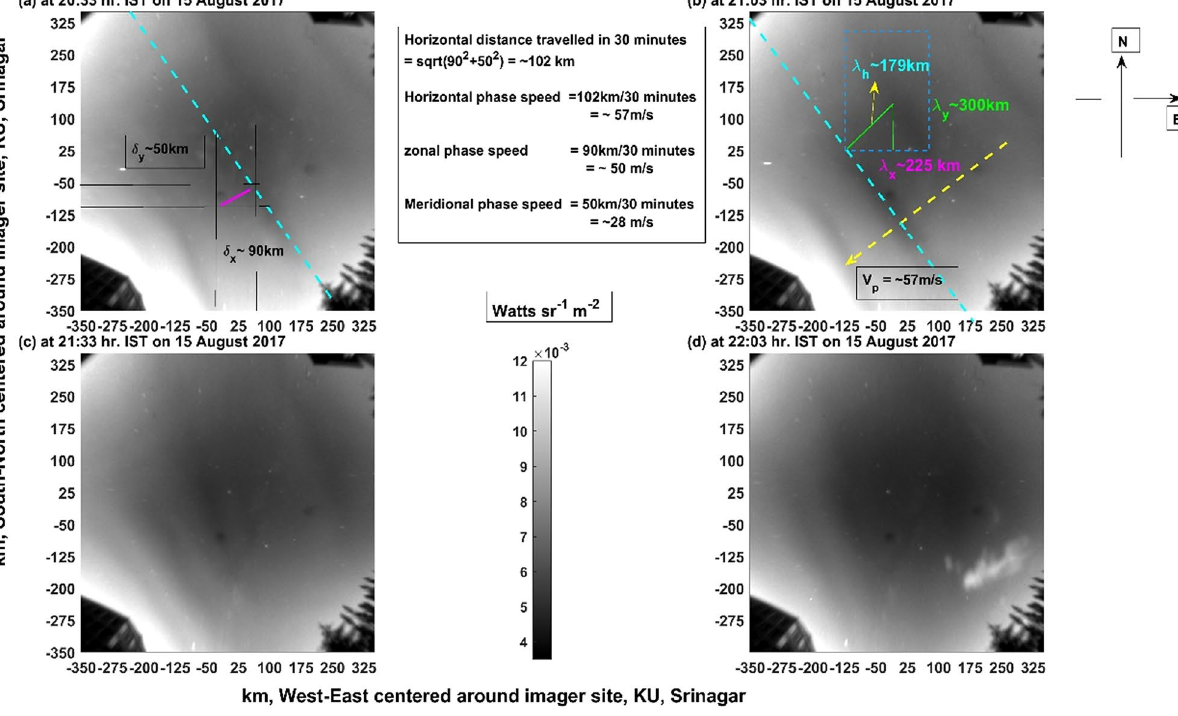
15 August 2017. In total, there are 28 panels of figures, each of which is obtained for an individual scan period of 100 s starting from 20:33 IST (Indian Standard Time = UT + 5:30 h) onwards and the time interval between two panel is about 4 min. It can be noticed that the panel at 20:33 IST shows diffused dark bands and in the sub- sequent panels the bands appear moving towards the south-west direction. The bands (phase fronts) are aligned along the north-west and south-east directions and the normal to these bands move towards the south-west direction. With time, multiple bands arrive in the field of view of the imager and move towards the south-west direction. There are three dark bands easily visible until 21:57 IST and afterwards only two bands are visible with the last band appearing at further distance from its nearby band compared to other inter-band distances. It can also be noted that the bands start to align along the north–south direction (meridian) as time progresses. At 21:57 IST, the bands are aligned almost parallel to the North–South direction. The last wider dark band, aligned along the meridian, continues to move towards the west at 22:00 IST. After reaching the centre of the image (over head of Srinagar), the dark band widens with time and at 22:07 IST, the dark band expanded in such a way that the whole image appears dark with no signatures of movement. Figure 2 shows un warped images of four panels of Fig. 1 in geographical coordinates (covering the pixel number ranges of 101:400 and 101:400 in the east–west and north–south directions respectively). They cover the horizontal space of ± ~ 350 km in the north–south direction (y-axis) and in the east–west direction (x-axis) at the height of ~ 250 km over KU, Srinagar. This is in contrast to that of Fig. 1 which is in pixel coordinate (512 by 512). The image size is truncated to the pixels range 101–400 (instead of 1–512) which corresponds to maximum zenith angle (field of view) of ~ 57° for all the three filters to avoid unnecessary interfering signals (say surround- ing street lights, buildings, trees) coming from nearby ground locations surrounding the imager site. Important quantitative information like (1) inter-band separation distance or horizontal wavelength, (2) band moving speed and direction and their time evolution is extracted from these images. It is also illustrated in Fig. 2 as to how the horizontal wavelength, speed and direction are estimated. It is observed that initially the horizontal wavelength (spatial separation between two white or dark bands) observed is about 200 km (~ ± 15 km, Fig. 2a) and within half an hour it became about 180 km (~ ± 10 km, Fig. 2b) and in the next half an hour it became about 60 km (± 8 km, Fig. 2c). In the next half an hour, the waves begin to disappear. As the bands cover the whole image, it is estimated that the total length of each of the bands is of the order of 900 km. Since the horizontal wavelength is significantly varying with time, it is difficult to find the exact speed of the moving phase front of these MSTIDs. The calculated speed of the phase front turns out to be around 57 m/s (~ ± 5 m/s). The four panels in this figure (Fig. 2) are separated in time by about half an hour beginning at 20:33 IST. The intensity values are obtained by taking in to account of the calibration of the imager at 630 nm but with band width of about 2 nm. The Van Rhijn